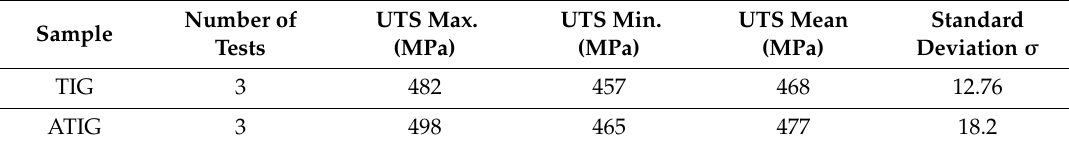
Figure 12. Fracture zones in base metal, TIG weld and in ATIG weld.